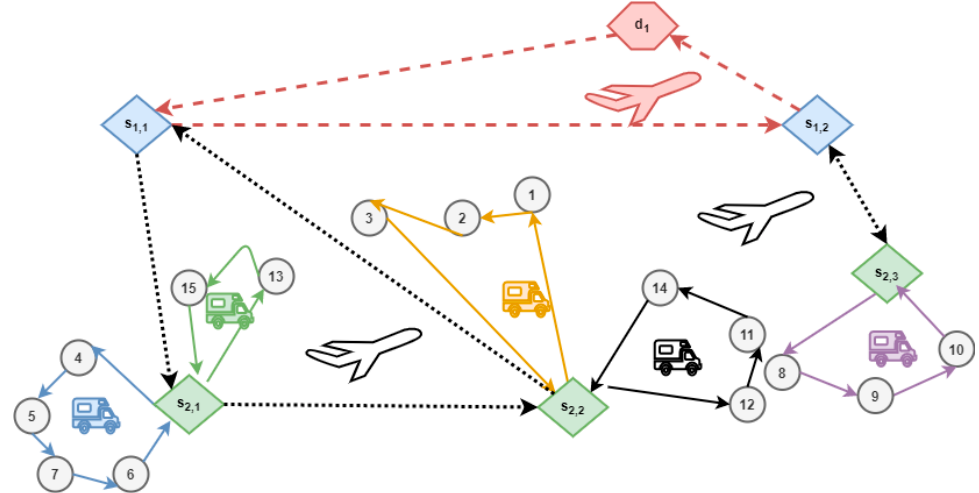
Figure 7. The multi-echelon system.